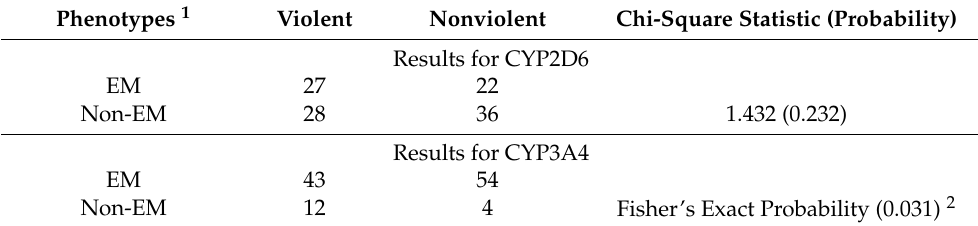
Table 2. Chi-square tests of the distribution of phenotypes on a per gene basis. Phenotypes